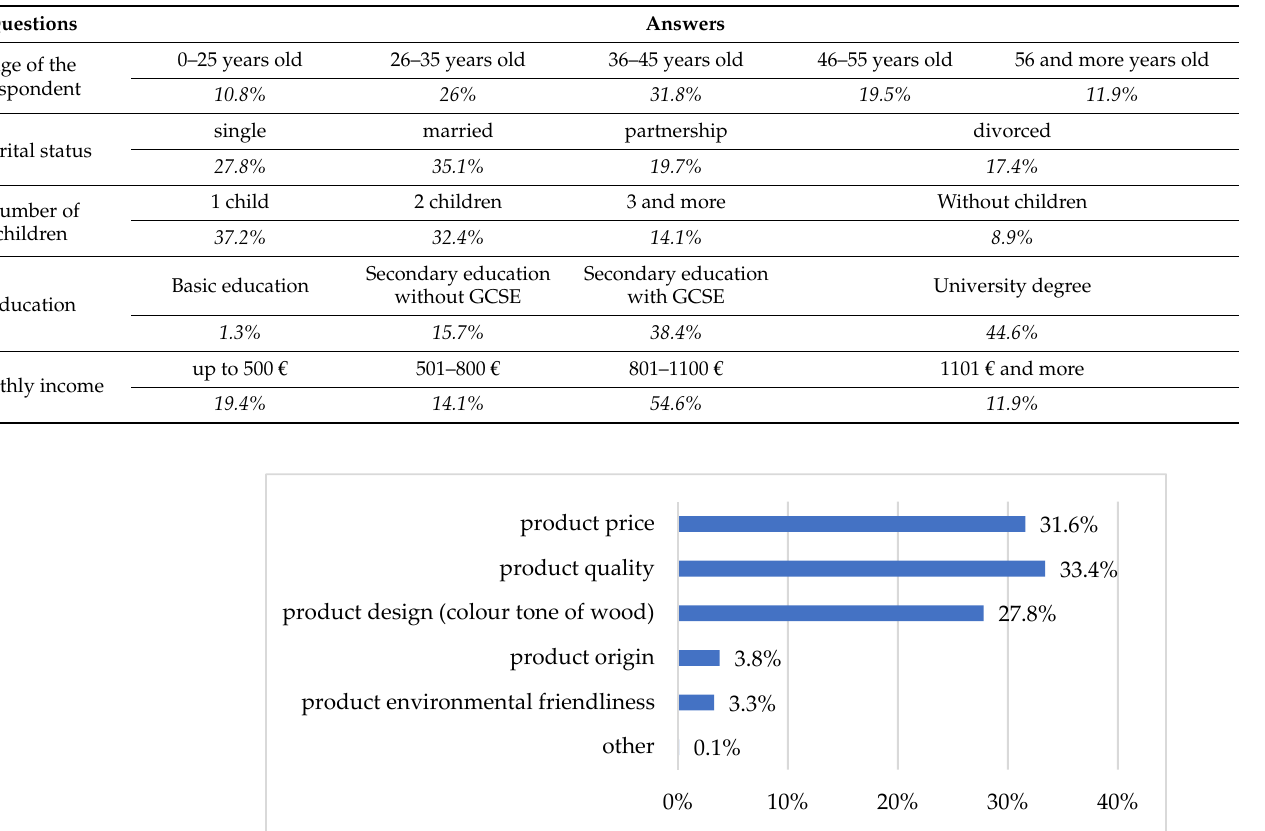
Table 3. Characteristic features of the respondents.